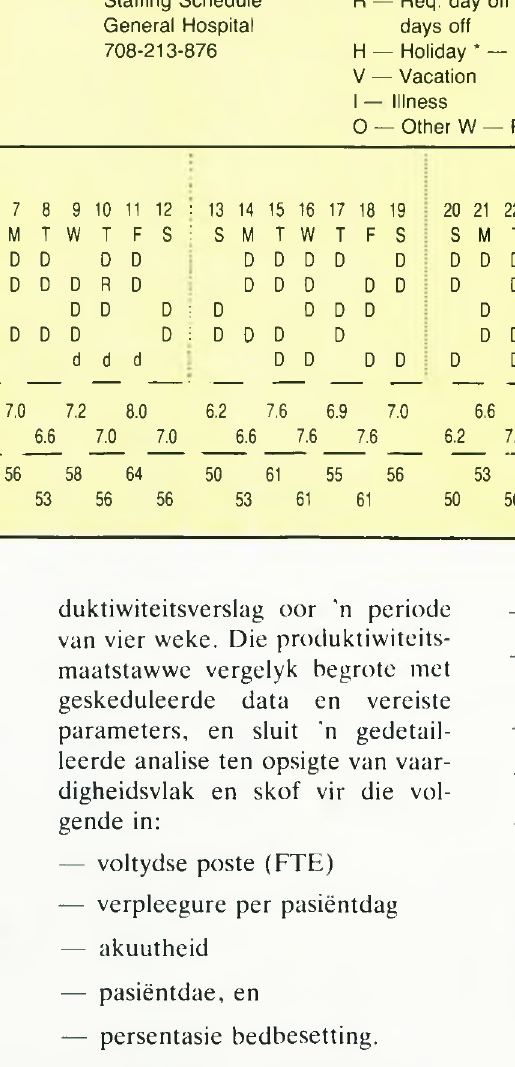
FIGUUR 3 Maandelikse wissellys vir die dagskof Unit /